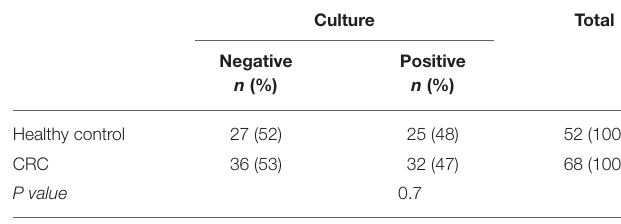
TABLE 2 | Data on Bacteroides fragilis culture.